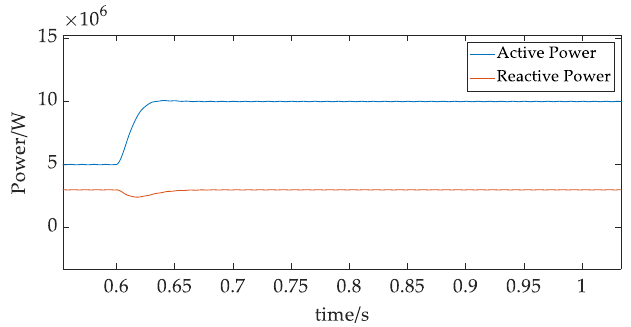
Figure 18. Output power under improved VSG control.